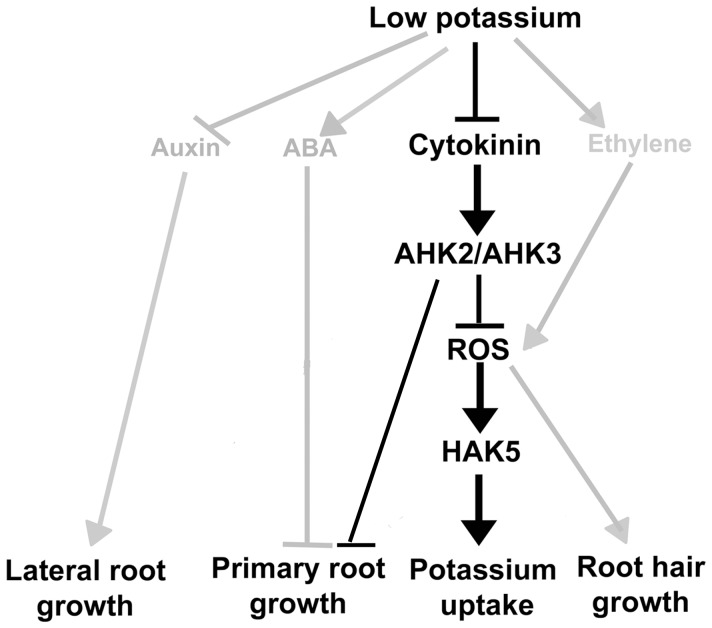
A schematic model for the roles of CKs in low K signal pathway.Low K conditions lead to reduced levels of endogenous CKs, which are negative regulators under these conditions. Lower CK levels result in ROS production, HAK5 expression, and then altered root growth. Previous studies showed that ethylene is a positive regulator in low K signaling that controls ROS production, HAK5 expression as well as root hair growth [13]. ABA [30] and auxin [12] also are involved in controlling low K signaling pathway. Arrowhead line, positive regulation; bar-head lines, negative regulation; gray color, previously identified; black color, identified in this study.